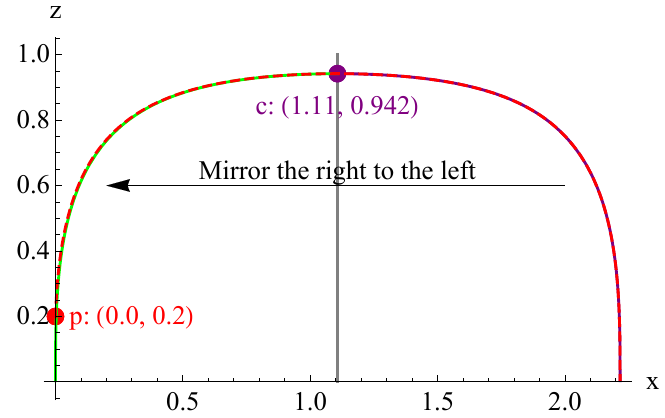
Figure 4 . The cartoon of obtaining the full z ( x ). The red dashed curve is the minimal curve started from p = (0 ; 0 : 2) (red dot) with z 0 ( x ) = 10637 : 3. The bottom point is at c = (1 : 11 ; 0 : 942) (purple dot), and the purple dashed line is the segment from c to the right endpoint. The green curve is the mirror image with respect to the gray vertical line through c . Therefore, the union of the green line and the purple line is the full solution of z ( x